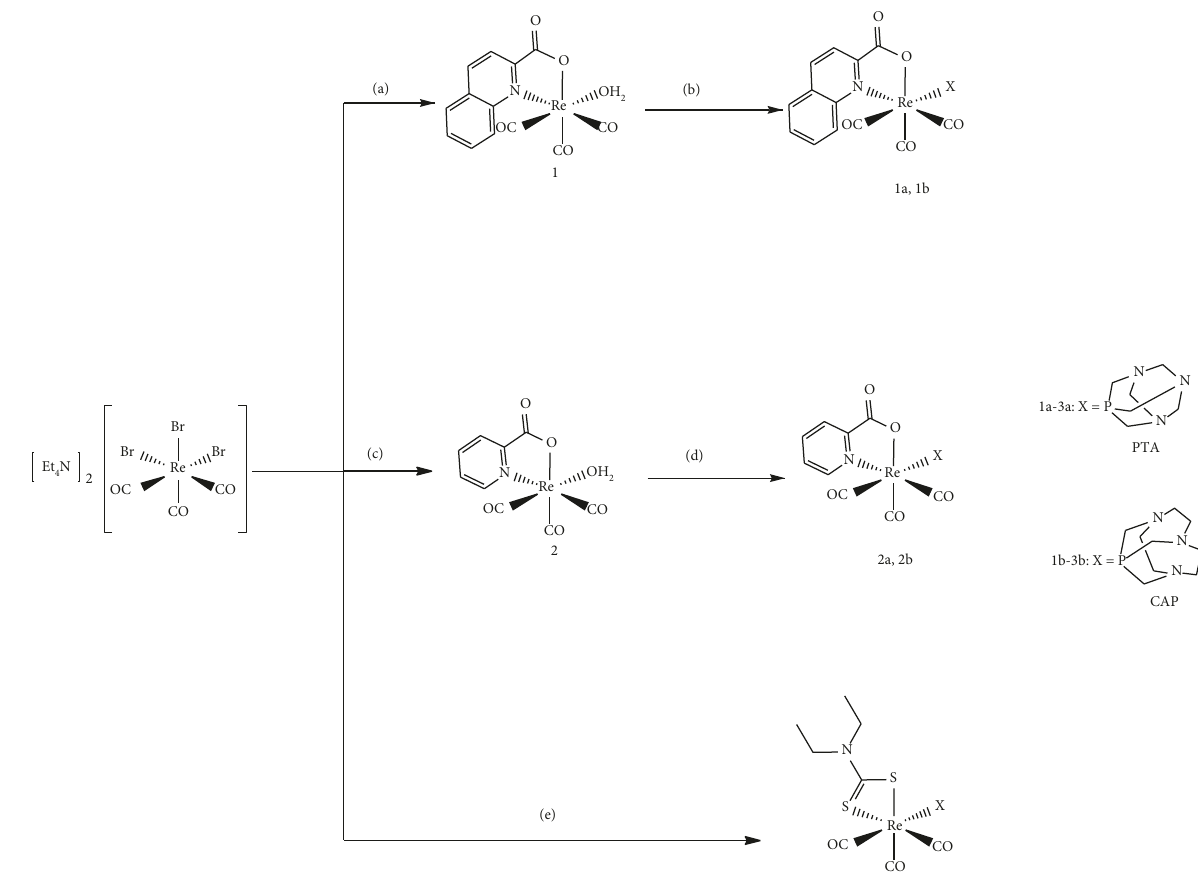
Scheme 1: Synthesis of complexes 1a-3a and 1b-3b . Reactions and conditions: (a) quinH, H H 2 O, 70 ° C, 3h; (d) X, MeOH, reflux, 2h; (e) Et 2 SS, X MeOH, reflux,